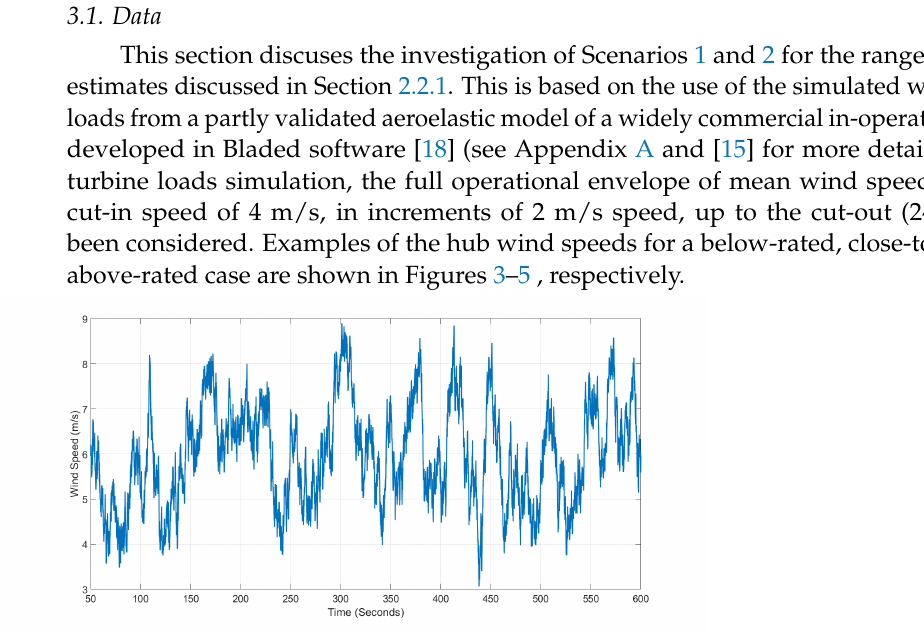
Figure 3. Aeroelastic model results for wind speed for a below-rated wind speed of 6 m/s.